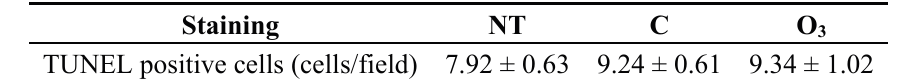
Figure 7. The effect of local administration of ozonated water on size of areas of tumor necrosis. The data represent the mean ± SE; n = 5 in the NT and C groups, n = 6 in the O 3 group. * p < 0.05 compared to the NT group by using the Tukey–Kramer test. NT: non-treatment group; C: local administration of sterile distilled water group; O 3 : local administration of ozonated water group. Table 1. The number of erminal deoxynucleotidyl transferase-mediated deoxyuridine triphosphate-biotin nick-end labeling (TUNEL) positive cells in